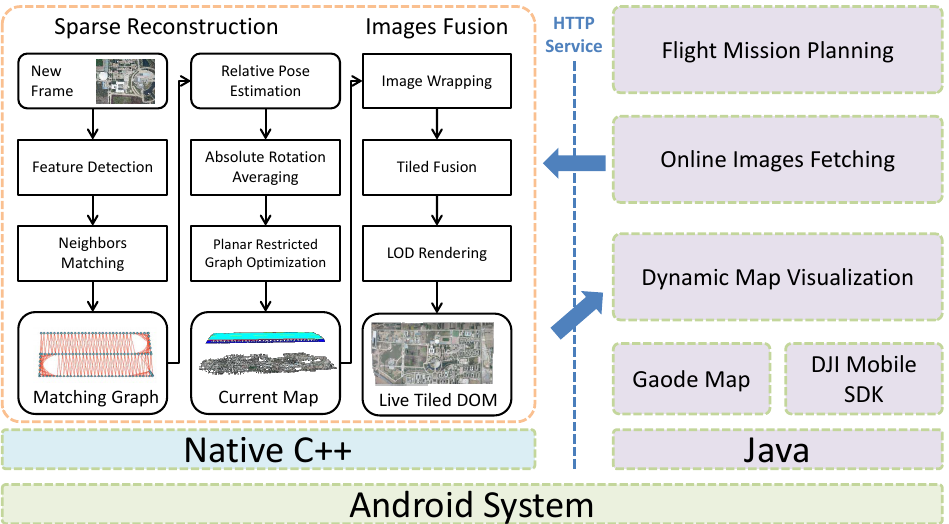
Figure 2. The framework of our system on android devices. All stitching algorithm pipelines are written by C++, which runs in the linux native layer, and the Java-based user interface (UI) calls live mosaic service through HTTP API. A way-point flight mission is planned and uploaded through DJI Mobile SDK, and images are fetched online with GPS information. The mosaic algorithm receives these images and stitches them incrementally during the flight. In addition, a tiled dynamic map layer is served though HTTP interface and visualized with GaoDe Map